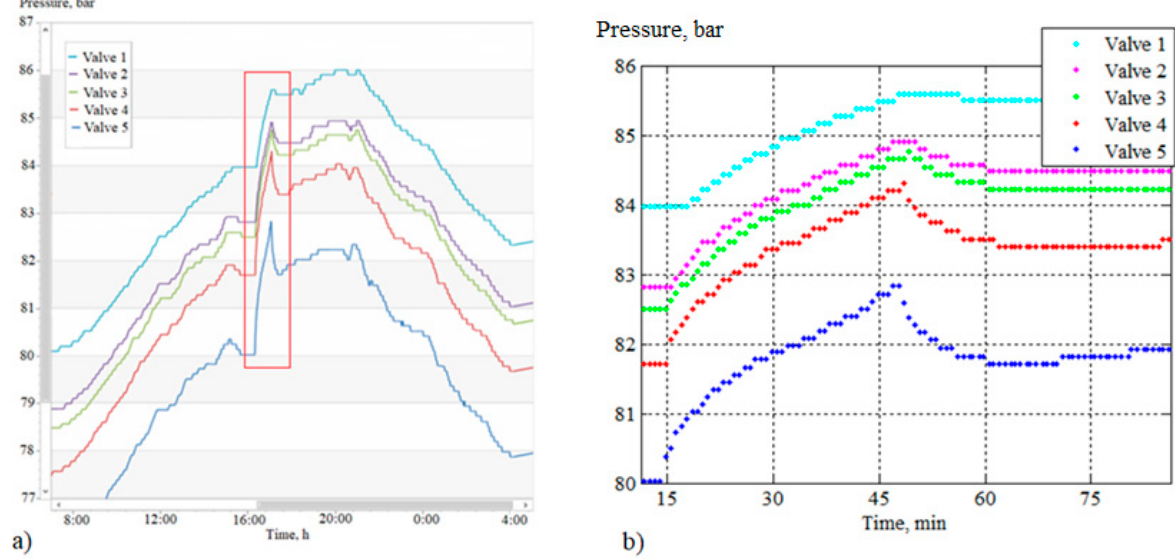
waves, these expectations were justified; for compression waves, they were not justified. Figure 3. Propagation of the compression wave. Example 1: ( a ) pressure changes at gauging stations during the day; ( b ) pressure waves for an hour and a half, corresponding to the red rectangle in ( a ).